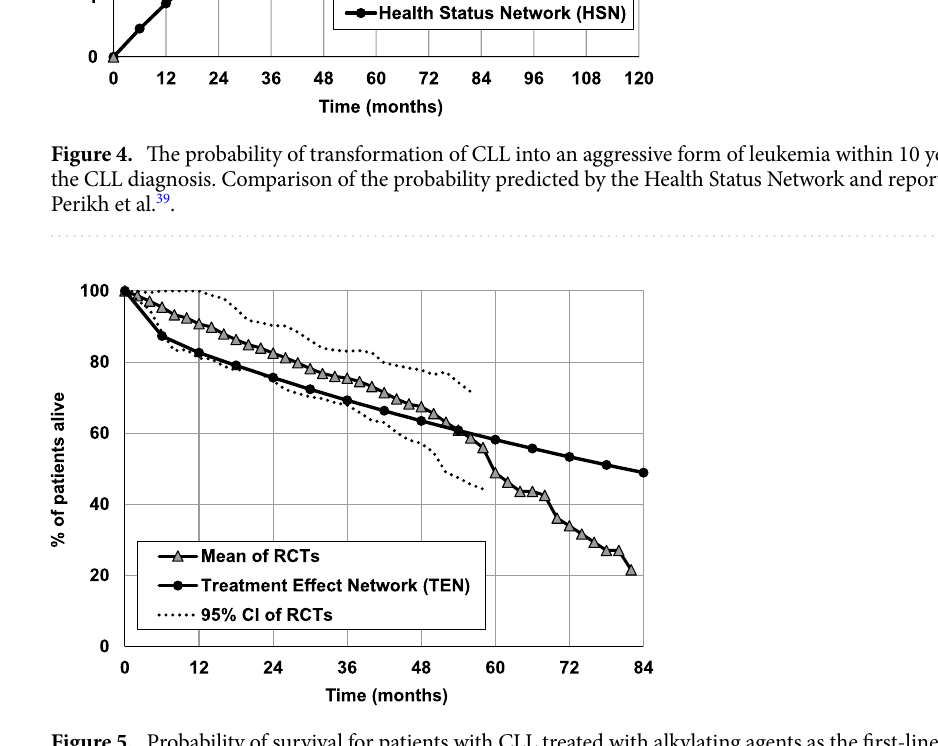
Figure 5. Probability of survival for patients with CLL treated with alkylating agents as the first-line treatment. Comparison of the probability predicted by the Treatment Effect Network and calculated based on results of RCTs 40–42 . The dotted lines indicate 95% confidence intervals (95%